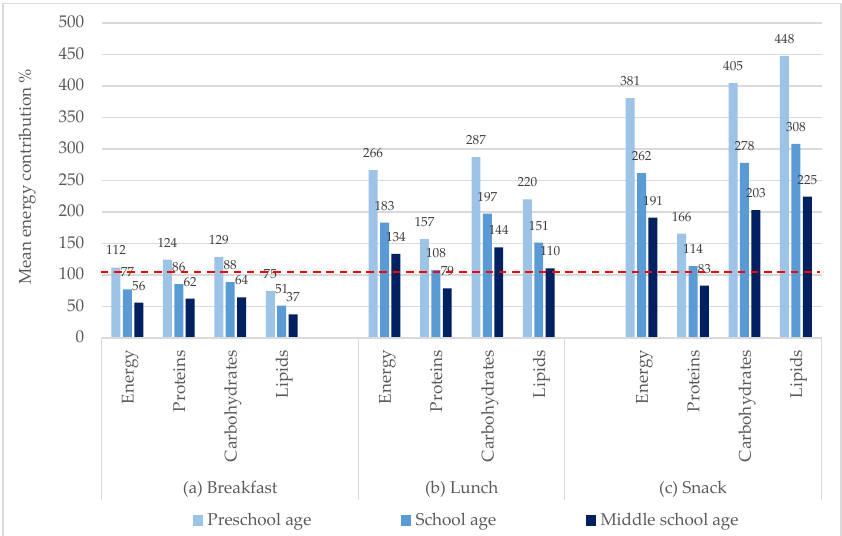
Figure 3. Mean energy and macronutrient contribution of kid’s meals regarding the mean recommended requirements for ( a ) breakfast, ( b ) lunch, and ( c ) snack, by school age (%).